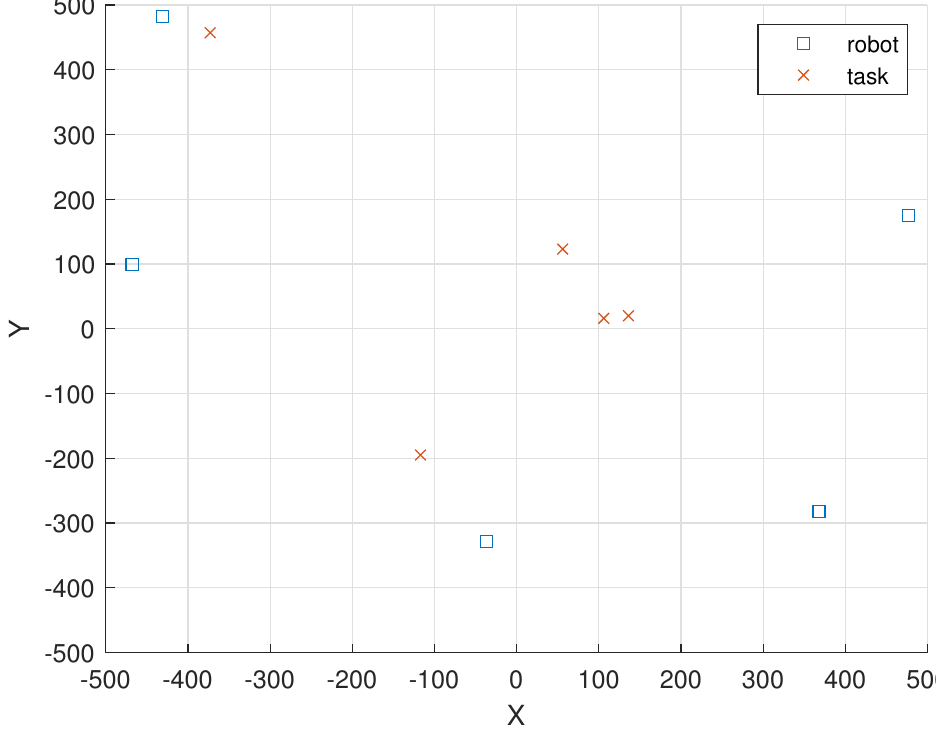
Figure 6. The locations of the five Markov EH robot nodes and the locations of the five tasks are represented as “square” and “cross” markers,